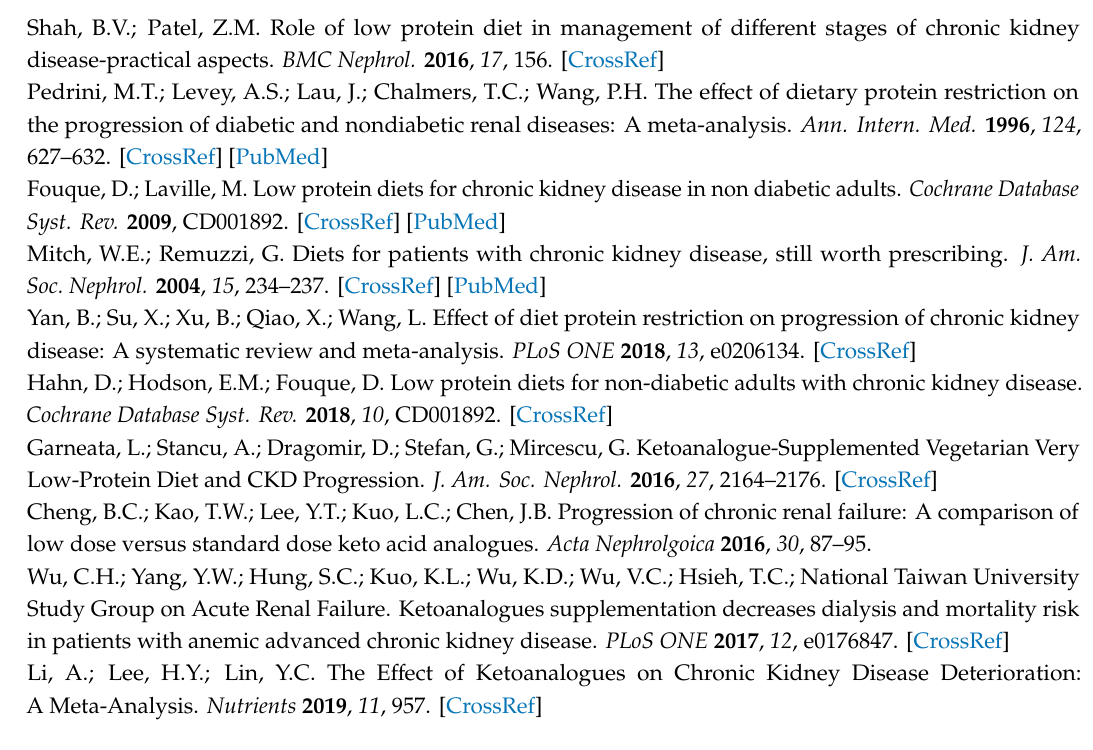
Table S1: Charlson Comorbidity